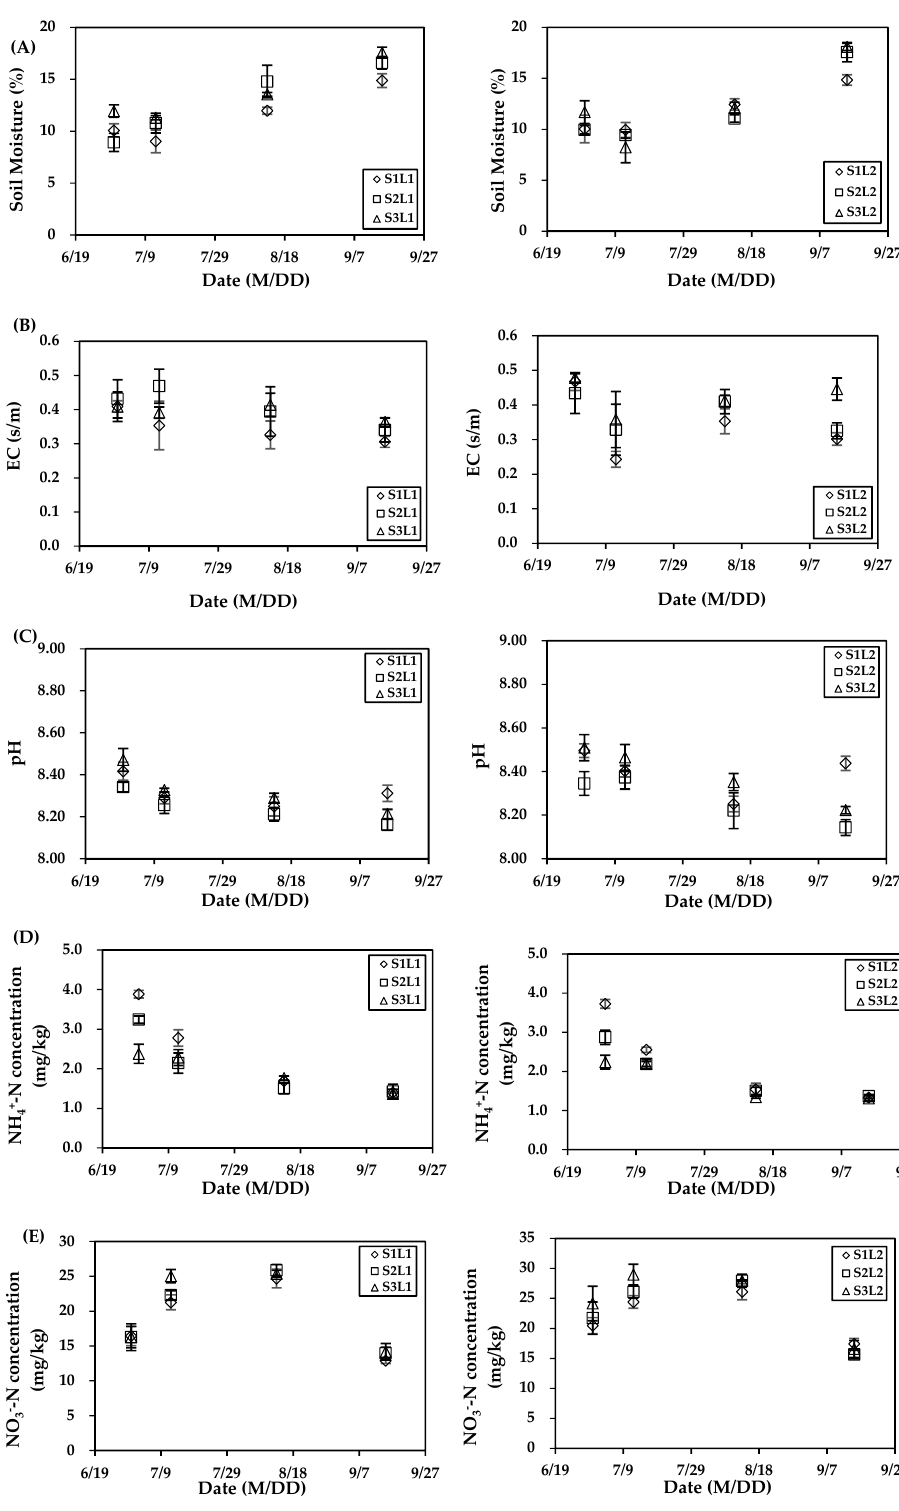
Figure 4. Variation of ( A ) soil moisture, ( B ) electrical conductivity—(EC), ( C ) pH, ( D ) NH 4 + -N concentration, and ( E ) NO 3 − -N concentration for different irrigation water salinity (S1, S2, and S3 for 2 g/L, 3.5 g/L, and 5 g/L, respectively) and alternate irrigation regimes (L1 and L2 for one saline water cycle and two saline water cycles, respectively). Symbols represent the mean value of the three repeated tests, and error bars represent standard